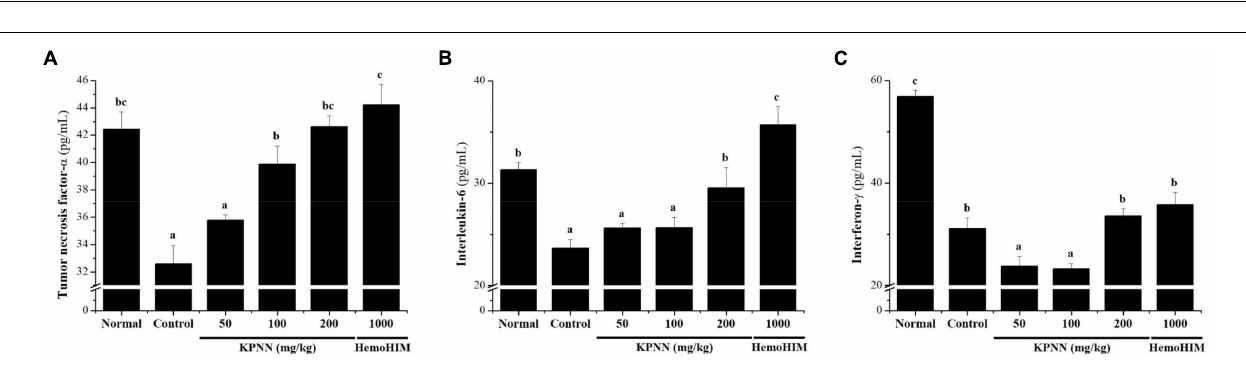
FIGURE 8 | Effect of KPNN on serum cytokine levels in rats with Cy-induced immunosuppression. Wistar rats were treated with saline, cyclophosphamide (Cy; 5 mg/kg/day), oral KPNN (0, 50, 100, and 200 mg/kg/day), or oral HemoHIM (1,000 mg/kg/day) once daily for 4 weeks. For cytokine analysis, blood collected in a conical tube was coagulated at room temperature for 30 min and then separated in a centrifuge at 3000 rpm for 10 min to collect serum. The separated serum was analyzed for (A) TNF- α , (B) IL-6, and (C) IFN- γ levels using an ELISA kit. The bar placed below the graph indicates significant differences at p < 0.05 ( n = 10). Bars labeled with different superscript numerals indicate p <